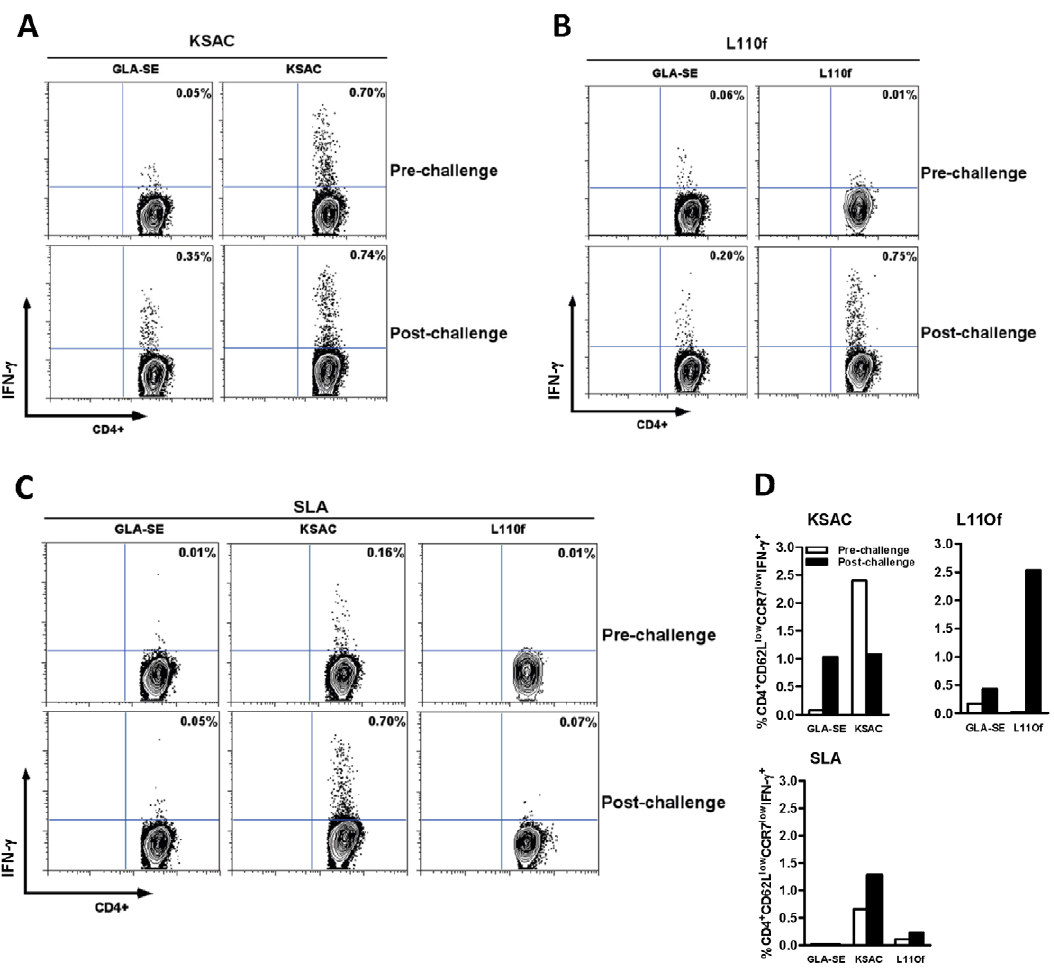
Figure 3. IFN- c -producing CD4 + T cells before and after challenge with L. major -infected sand flies. Mice were vaccinated subcutaneously with 10 m g KSAC + 20 m g GLA-SE, 10 m g L110f + 20 m g GLA-SE, or 20 m g GLA-SE alone. Splenocytes were analyzed three weeks after the last immunization (Pre-challenge) or one week Post challenge with L. major . Splenocytes gated on TCR b + CD4 + T cells for the percentage of IFN- c + CD4 + T cells produced after antigen stimulation (A–C). (A) Splenocytes from KSAC + GLA-SE- or GLA-SE-vaccinated mice stimulated with 20 m g recombinant KSAC in vitro ; (B) Splenocytes from L110f + GLA-SE- or GLA-SE-vaccinated mice stimulated with 20 m g recombinant L110f; or (C) Splenocytes from KSAC + GLA-SE-, L110f + GLA-SE-, or GLA-SE-vaccinated mice stimulated with 100 m g SLA in vitro . (D) Splenocytes gated on TCR b + CD4 + CD62L low CCR7 low T cell population for the percentage of effector memory CD4 + splenic T cells in mice vaccinated with GLA-SE, KSAC + GLA-SE or L110f + GLA-SE after stimulation with either KSAC, L110f or SLA. Three mice were used per group. Data are representative of two independent experiments.